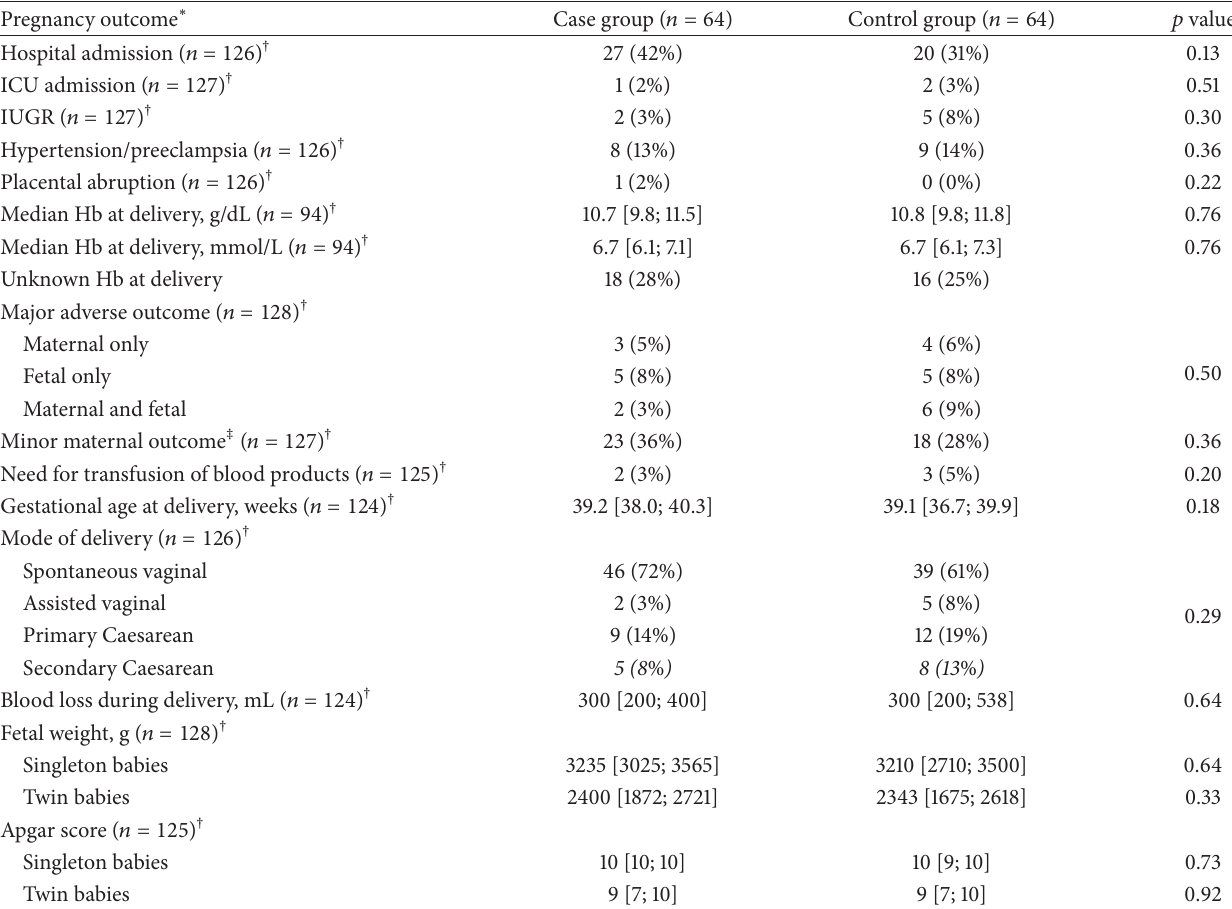
Table 3: Pregnancy outcomes in cases and